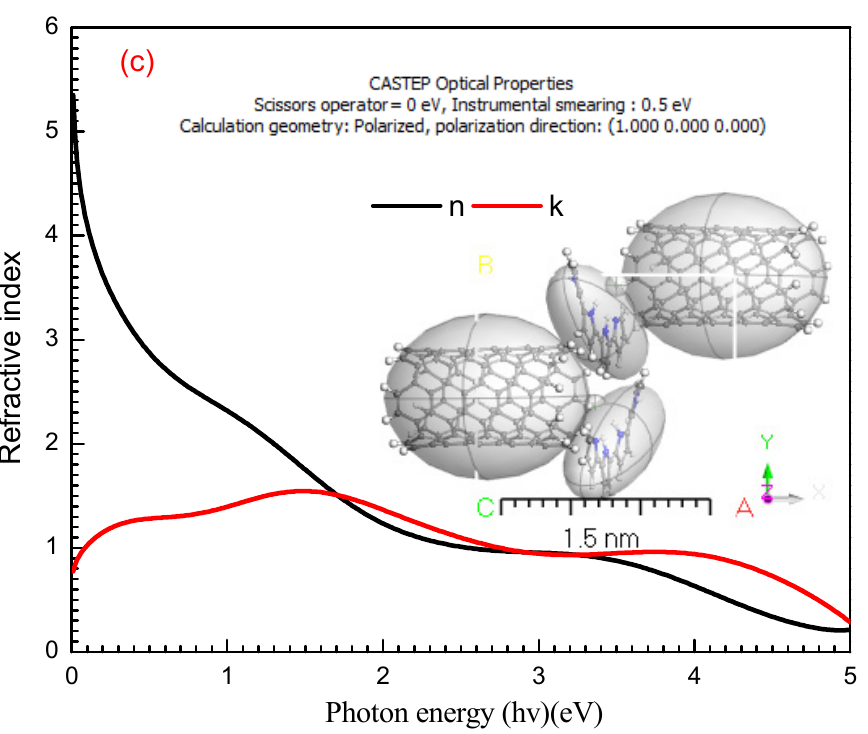
Figure 6. ( a ) Plot ( n ) vs. photon energy ( h ν ) eV, ( b ) Plot ( k ) vs. photon energy ( h ν ) eV for PPy and the different types of PPy/MWCNTs composites and ( c ) the simulated computation of ( n ) and ( k ) for PPy/MWCNTs composites as isolated molecule by using CASTEP/DFT.